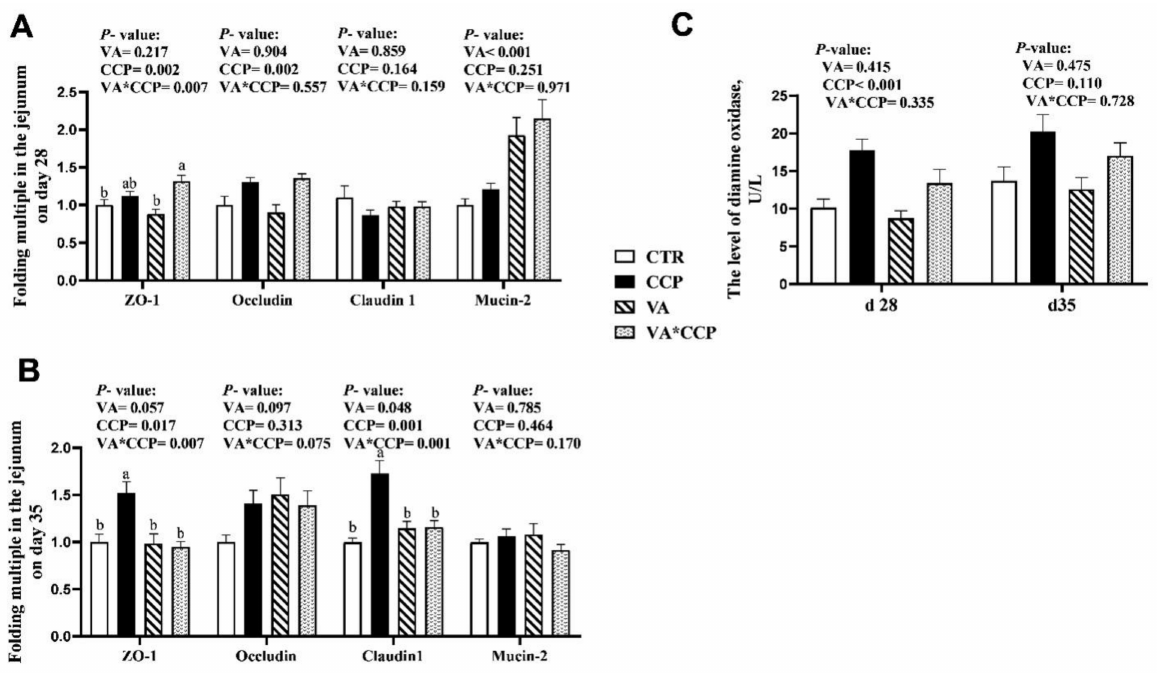
Figure 3. Transcription levels of jejunal barrier-related genes and serum DAO levels: ( A , B ) results of the jejunum barrier genes on days 28 and 35, respectively; ( C ) results of serum DAO. a, b Differ- ent pillar without common superscripts differ significantly ( p < 0.05). Data are presented as the mean ± standard deviation. CTR = control group; CCP = co-infected with coccidia and C. per- fringens group; VA = dietary supplementation with 12,000 IU/kg VA group; VA + CCP = dietary supplementation with 12,000 IU/kg VA and co-infected with coccidia and C. perfringens